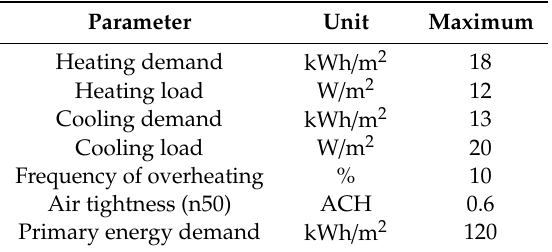
Table 1. Designing standards of passive